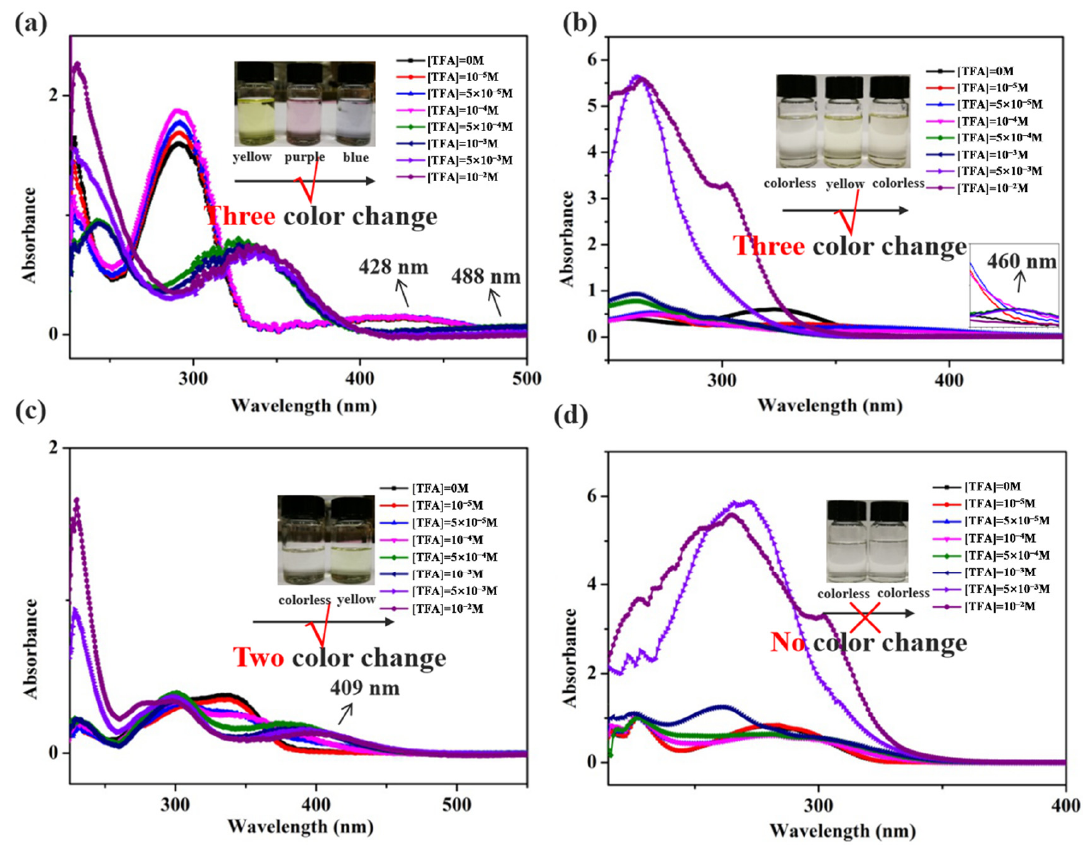
Figure 10. Changes in the UV spectra and colors of ( a ) PI , ( b ) NI , ( c ) TI and ( d ) FI solutions (5 × 10 − 5 mol/L in DCM) with increasing concentrations of TFA.